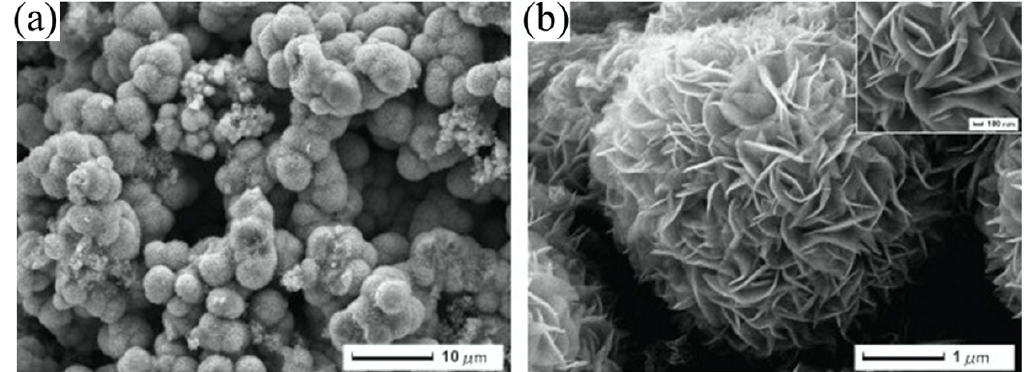
Figure 13. SEM images of 3 ‐ D flower like MoS 2 morphology. ( a ) flower ‐ like MoS 2 composed of a large quantity of uniform MoS 2 microspheres. ( b ) Magnified view of MoS2 microsphere. A MoS 2 is built from several dozens of nanosheets that connected through the center to form 3 ‐ D flower ‐ like structures. Reprinted from [234], Copyright 2015, with permission from Elsevier.